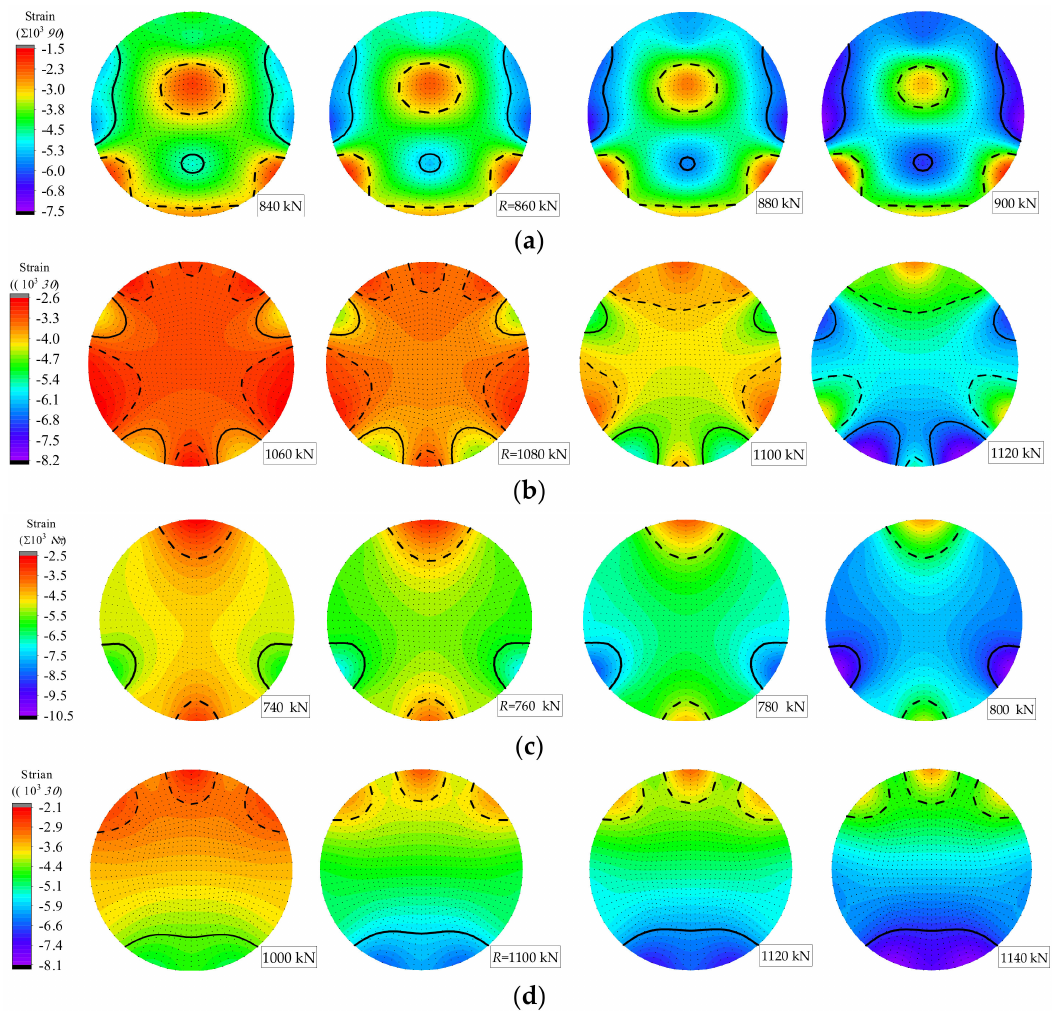
Figure 11. The strain fields of core concrete for di ff erent supports around their respective characteristic load R : ( a ) The strain fields of support-B around 860 kN; ( b ) the strain fields of support-C around 1080 kN; ( c ) the strain fields of support-D around 740 kN; ( d ) the strain fields of support-E around 1100